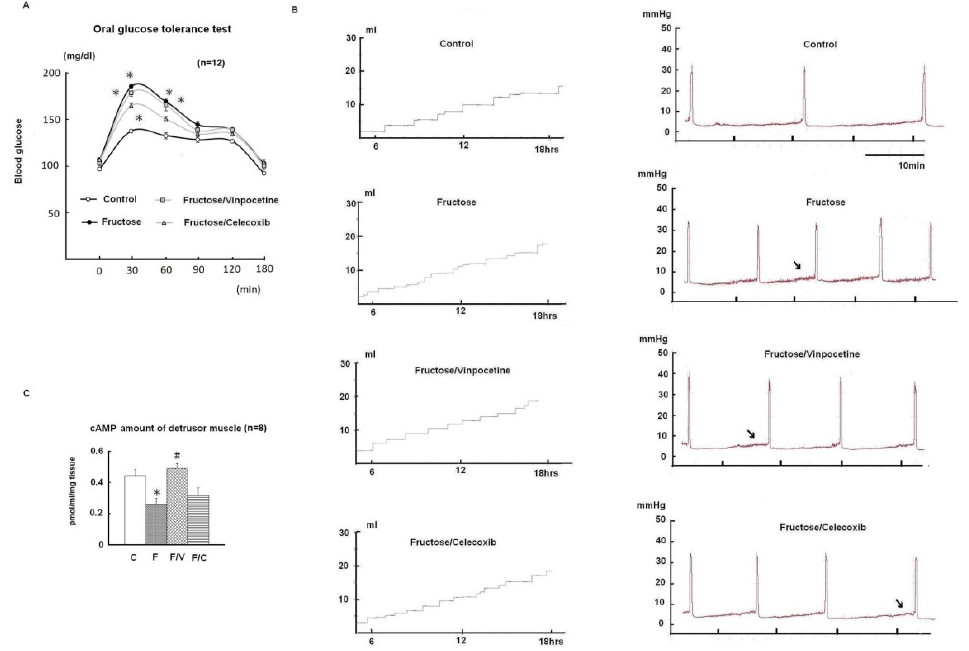
Figure 1. Glucose tolerance, micturition behaviour, and mucosa-denuded detrusor cellular cyclic adenosine monophosphate (cAMP) amounts of experimental animals. ( A ) The response curves of plasma glucose to oral glucose tolerance test, ( B ) metabolic cage study (left) and filling cystometry (right) among study groups, ( C ) the cAMP amounts of mucosa-denuded detrusor muscle in different groups. Data are represented in mean ± SEM. One-way ANOVA with Bonferroni tests were carried out (* shows significance in comparison with the control group; # shows significance in comparison with the fructose-only group). Arrows indicate the increased basal tone of cystometry. C: control; F: fructose; F/V: fructose/vinpocetine; F/C: fructose/celecoxib.